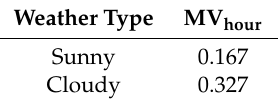
Table 3. Comparison of mean absolute percentage forecast error (MAPE) between sunny days and cloudy days.